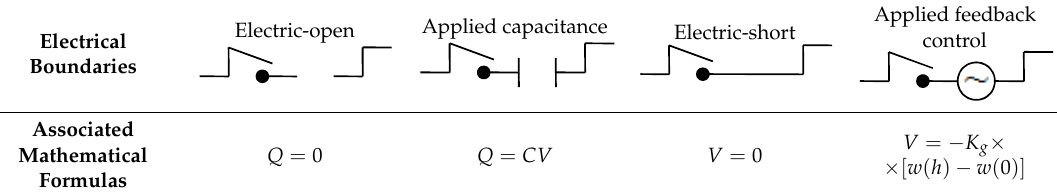
Figure 1. The schematic of the unit cell and its description in the global coordinate system of general, periodically laminated piezoelectric composites. Table 1. The mathematical formulas associated with various electrical boundaries 1–5 .